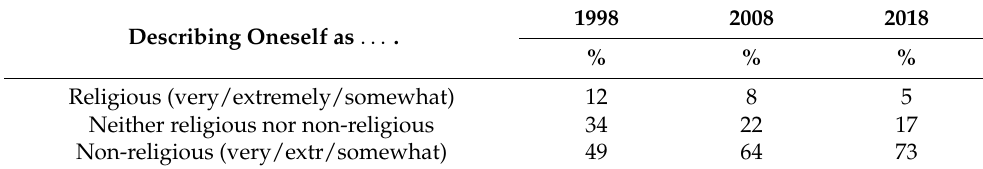
Table 1. Self-assessed religiosity of those who do not identify with a religion. Describing Oneself as . . .